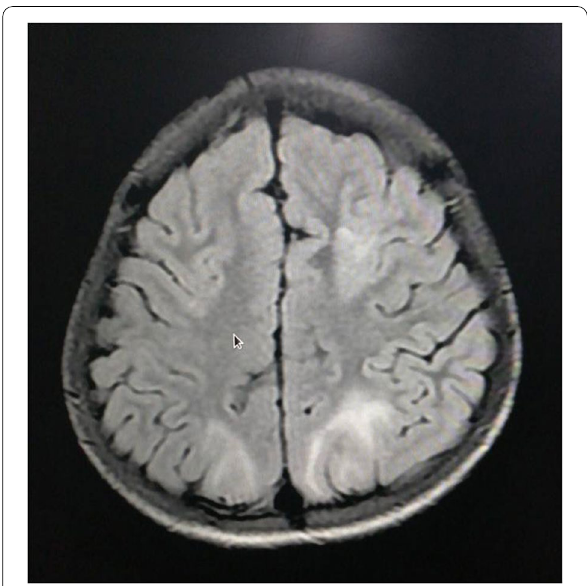
Fig. 1 MRI brain T2 FLAIR image showing hyperintensities in bilateral occipital, posterior parietal, and left high parietal lobe